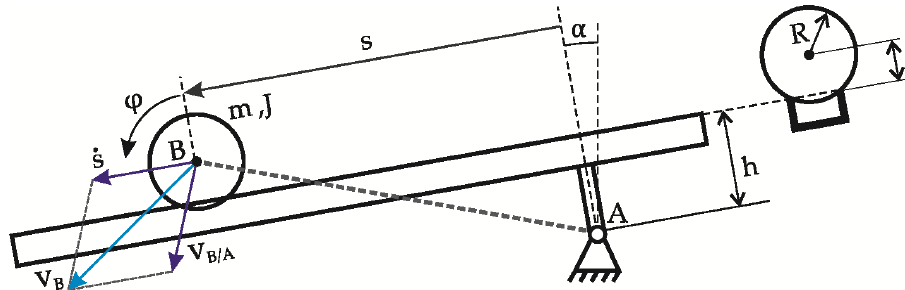
Figure 2. Scheme of the ball and beam system.